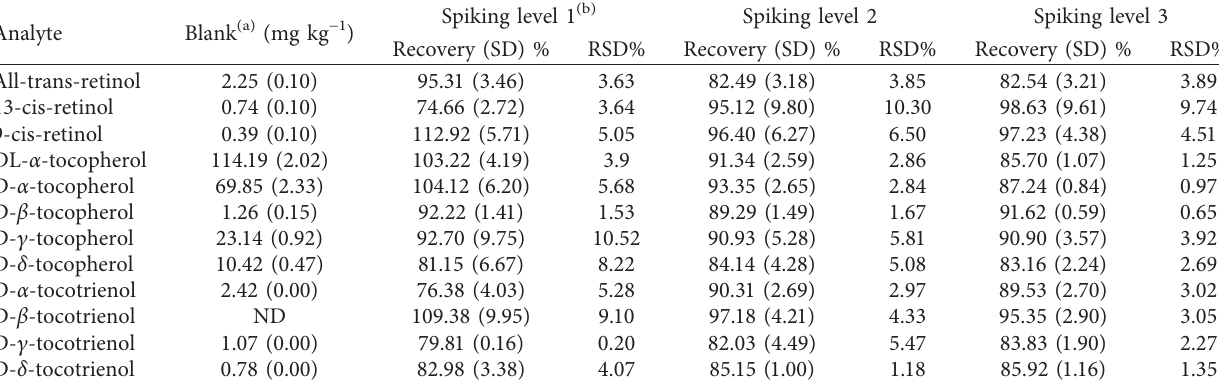
Table 2: Accuracy and precious in spiked infant formula samples ( n � 6).